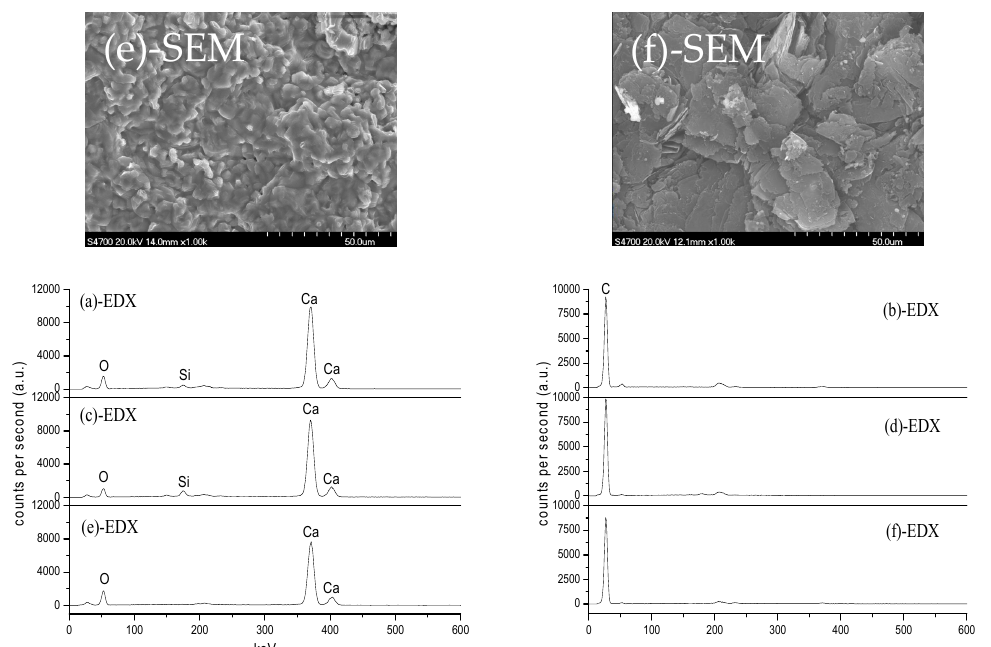
Figure 2. SEM+EDX analyses: ( a ) CaO (1500 ◦ C); ( b ) pure-C (1500 ◦ C); ( c ) CaO (+pure-C, 1500 ◦ C); ( d ) pure-C (+CaO, 1500 ◦ C); ( e ) CaO (+pure-C, 1700 ◦ C); ( f ) pure-C (+CaO, 1700 ◦ C).